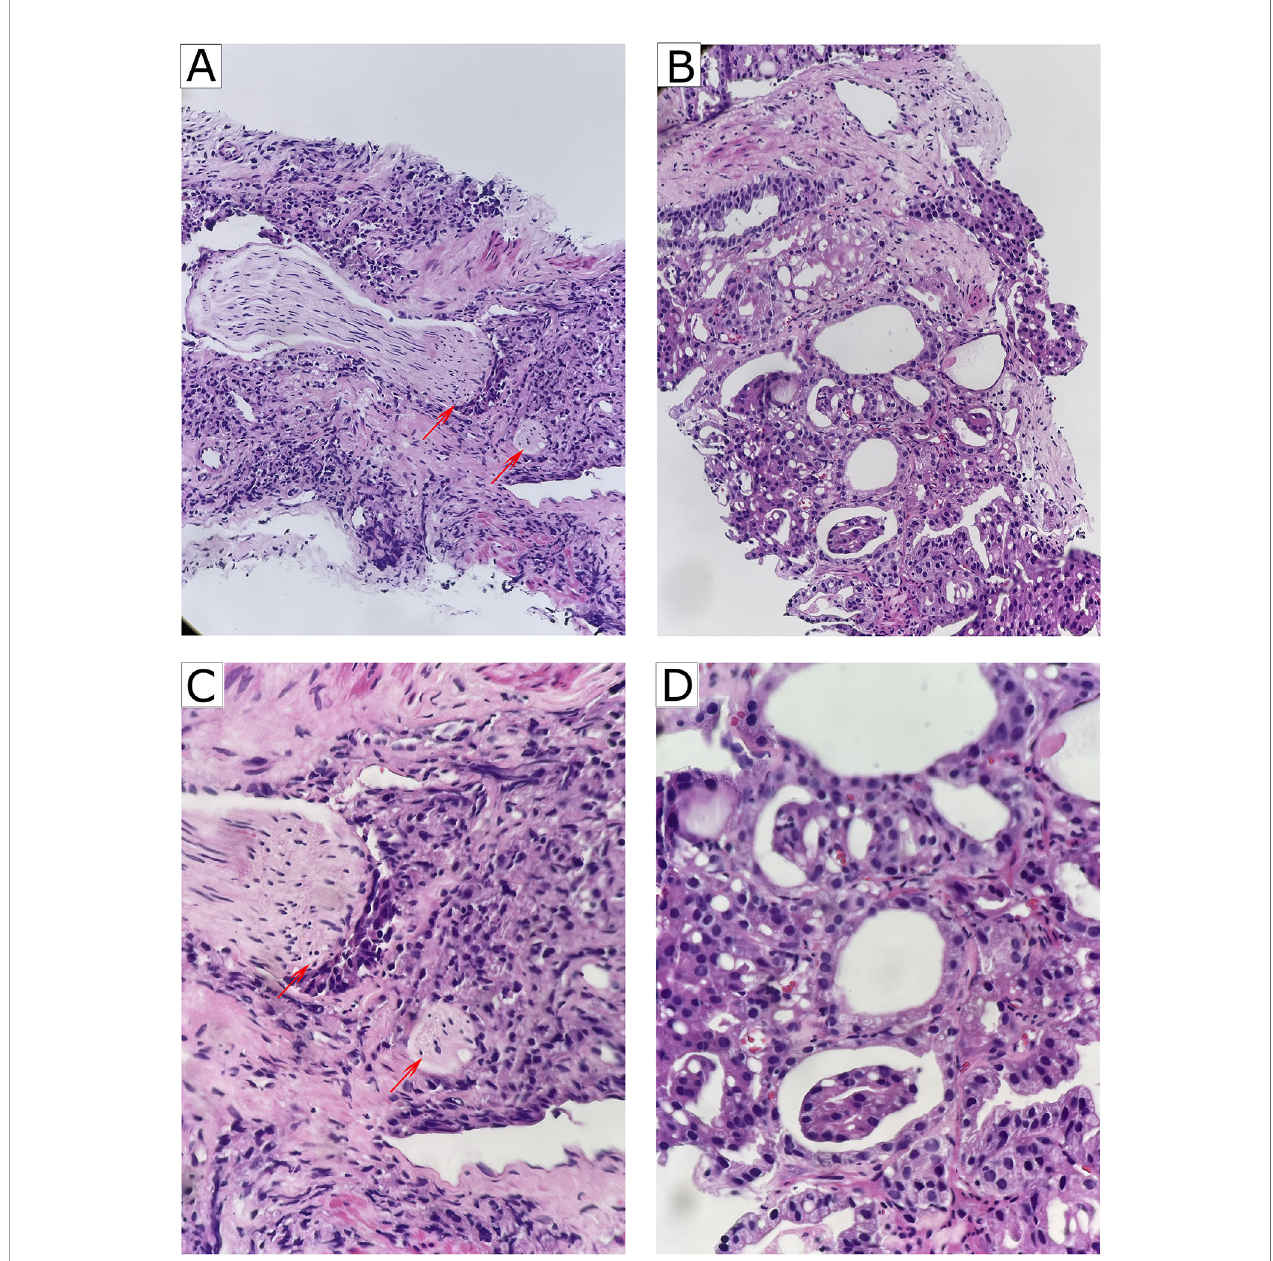
FIGURE 1 | Representative of PNI and non-PNI sections of HE staining from patients with PCa. (A) Representative image of PNI (HE, ×200). The nerves (red arrow heads) were invaded by surrounding cancer cells. (B) Representative image of non-PNI (HE, ×200) for comparison. (C) Higher magni fi cation of A (HE, ×400) showing that the nerves (red arrow heads) were invaded by surrounding cancer cells. (D) Higher magni fi cation of (B) (HE, ×400). PNI, perineural invasion; PCa, prostate cancer; HE,